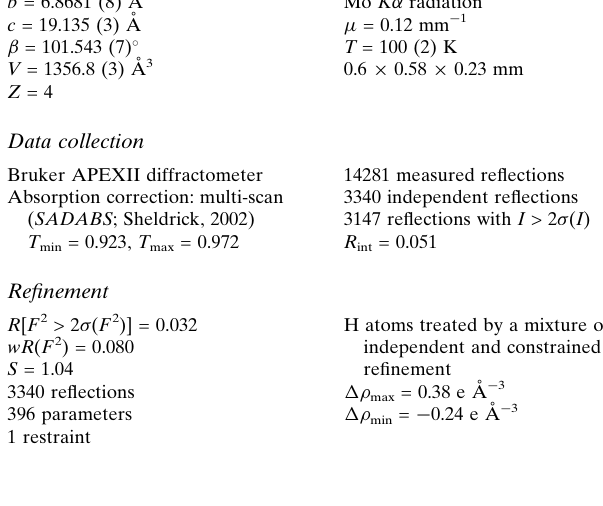
Bruker APEXII diffractometer Absorption correction: multi-scan